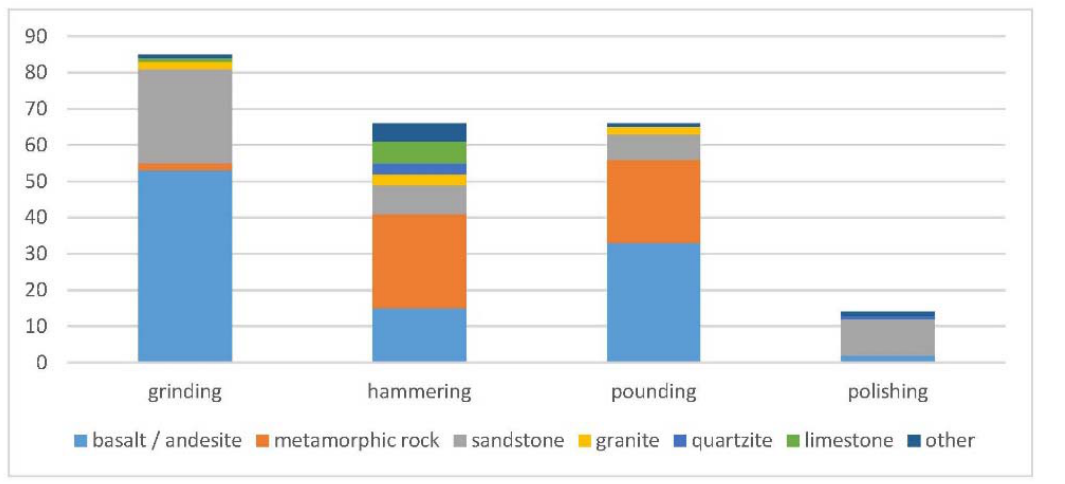
Figure 3. Selection of types of rock by great activities among Shulaveri-Shomu macrolithic tools (after data in Hamon